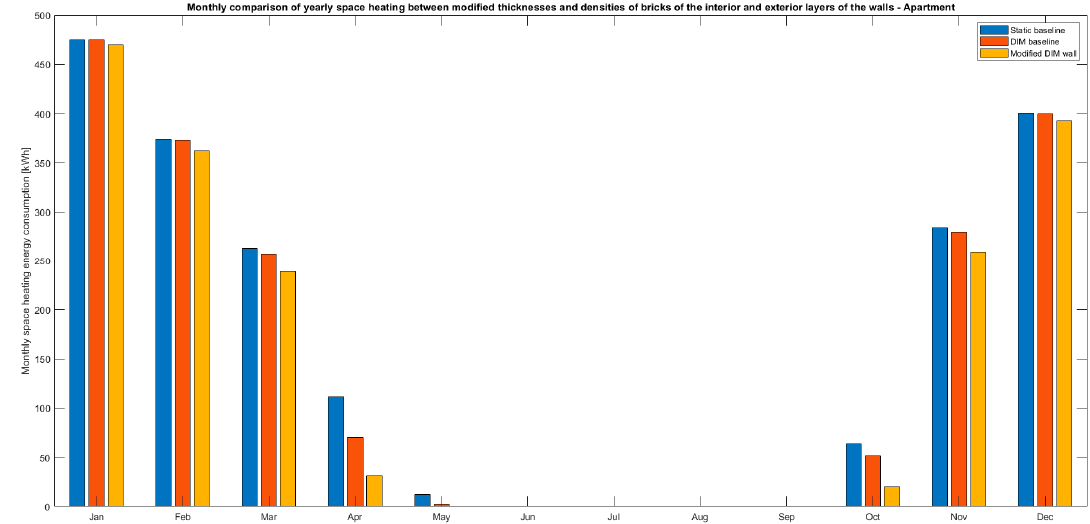
Figure 5. Monthly comparison of annual heating consumption energy for improved thicknesses and densities of the interior and exterior brick layer for the walls of the prototypical Belgian apartment.